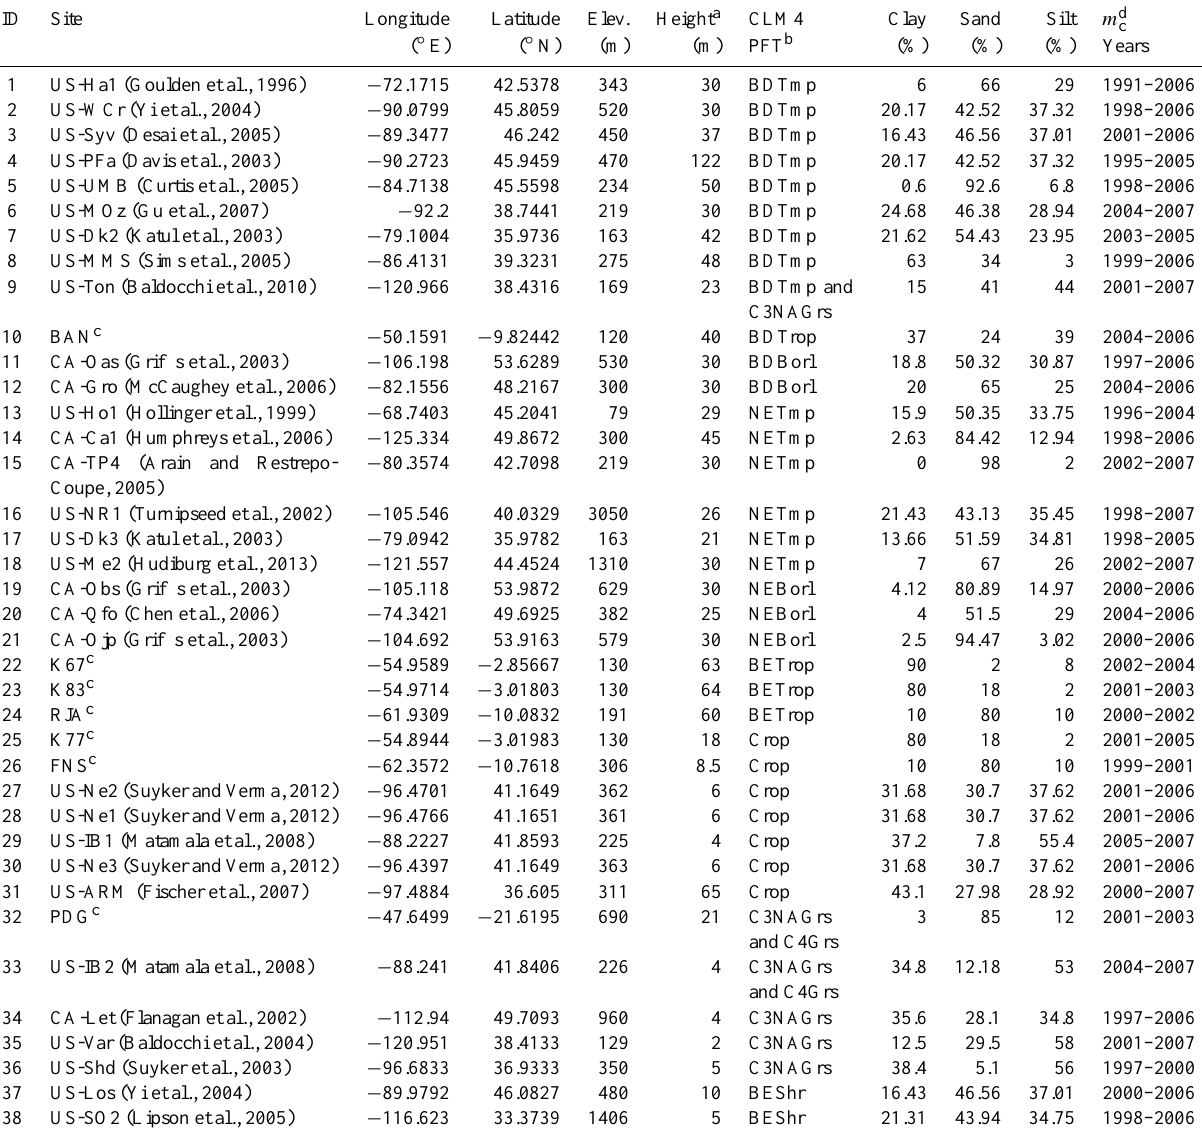
Table 1. Location, PFT, soil type and number of years of atmospheric forcing for each